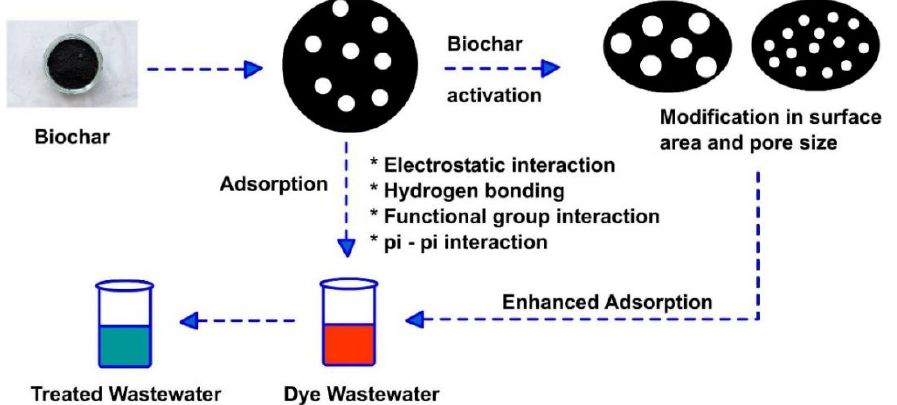
Figure 2. Schematic diagram of dye adsorption mechanism using biochar.